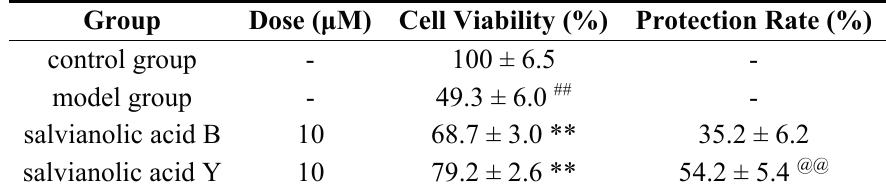
Table 2. Salvianolic acid B and salvianolic acid Y protect PC12 cells against H 2 O 2 -induced